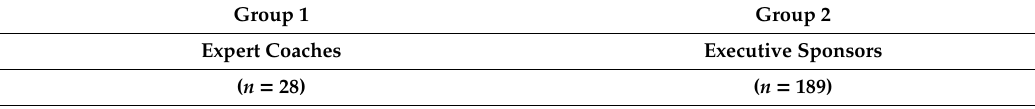
Table 1. Roles and responsibilities of the participant groups.